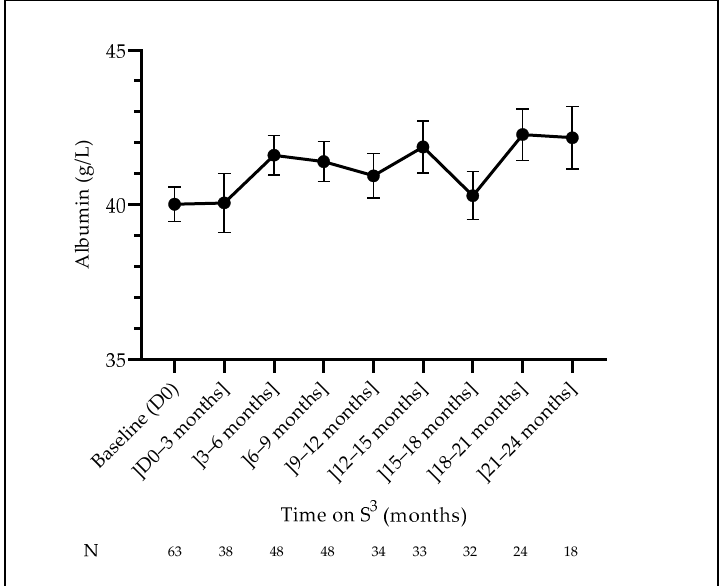
Figure 5. Evolution of plasma albumin concentrations (mean ± SEM).